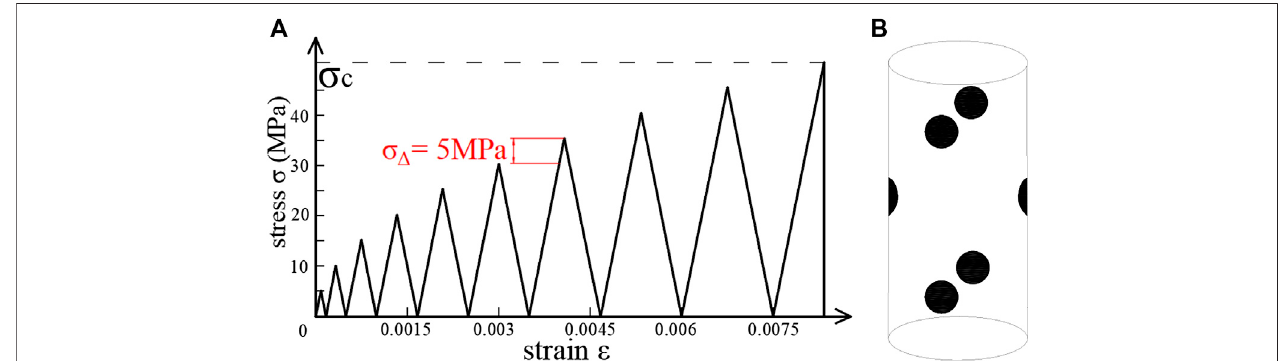
FIGURE 1 | Cyclic loading and unloading diagram. (A) v (cid:2) 0.15 mm/min; (B) v (cid:2) 0.2 mm/min